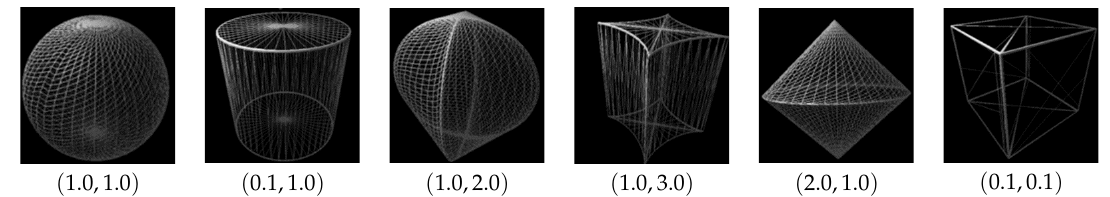
Figure 2. Various superquadric shapes according to ε 1 and ε 2 The caption below the figure shows the ( ε 1 , ε 2 )